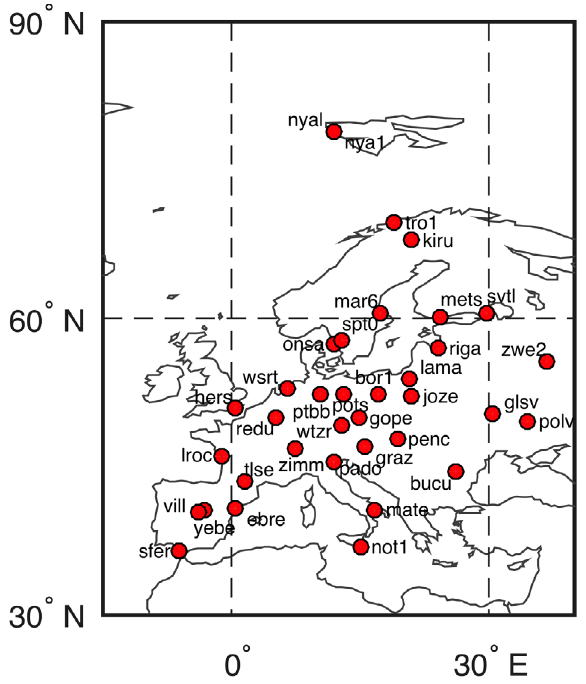
Figure 1. Locations of 36 selected GPS sites (marked by red dots) in western